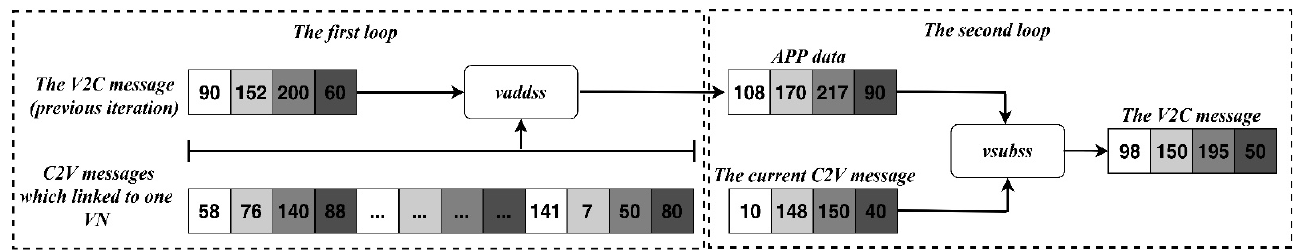
Figure 4. The update process of one thread in the check node update kernel (the data representation in the figure is an unsigned char type).